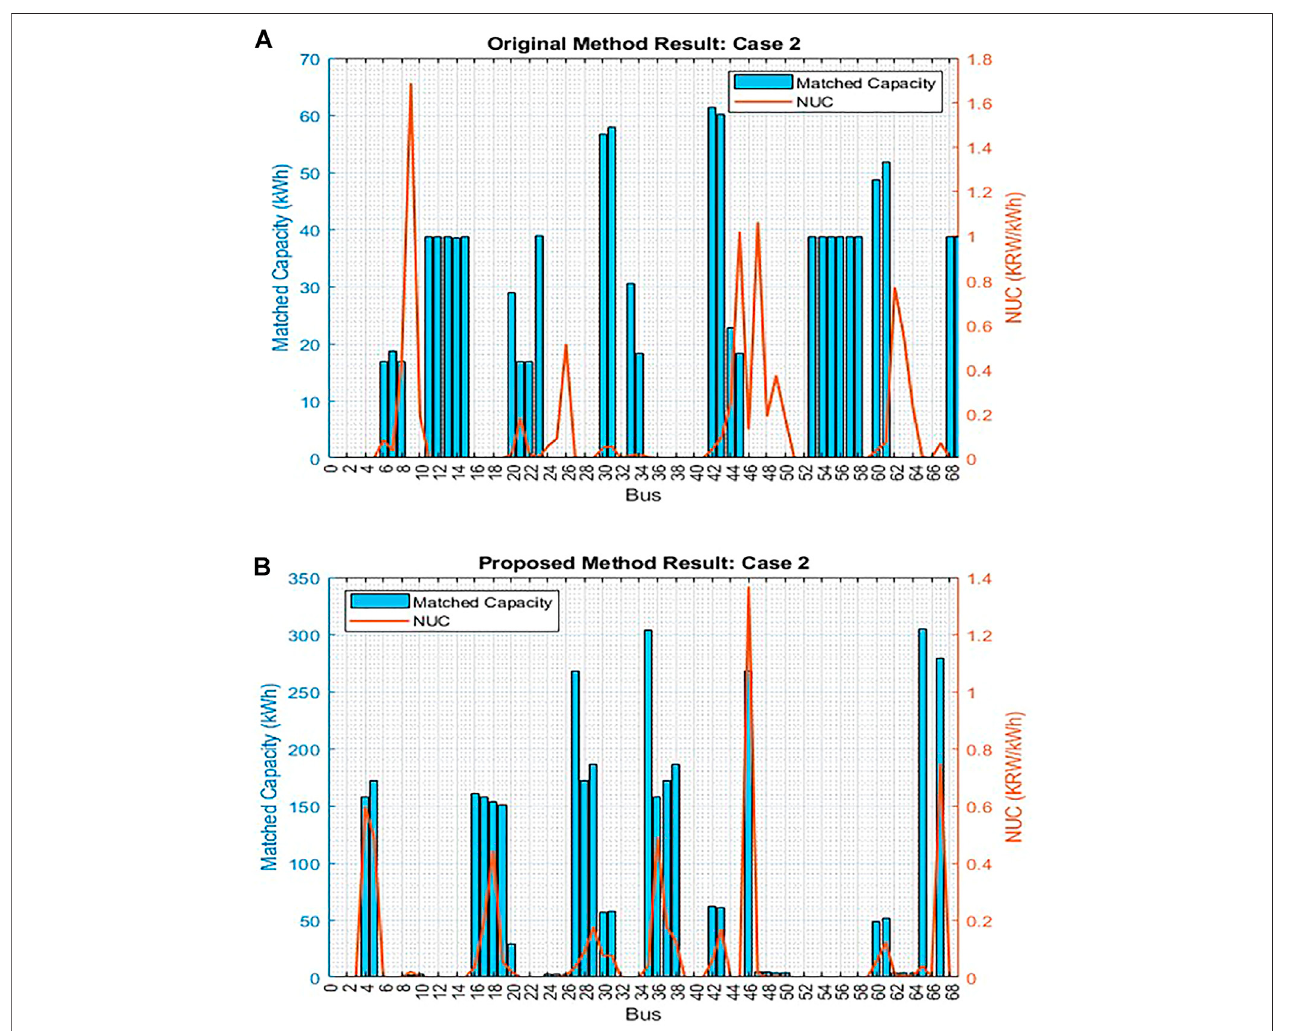
FIGURE 9 | Matched capacity of NUC allocation using the (A) original method and (B) proposed method.